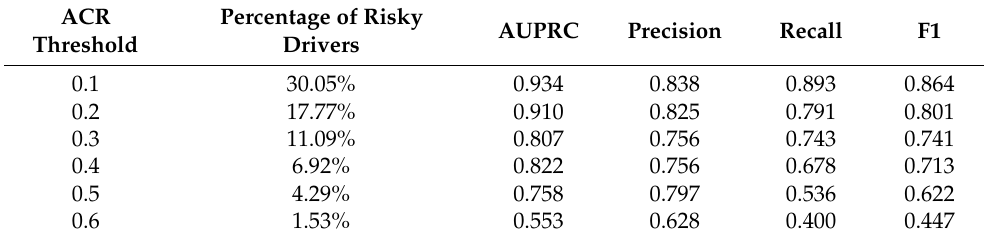
Table 4. Results of different ACR threshold